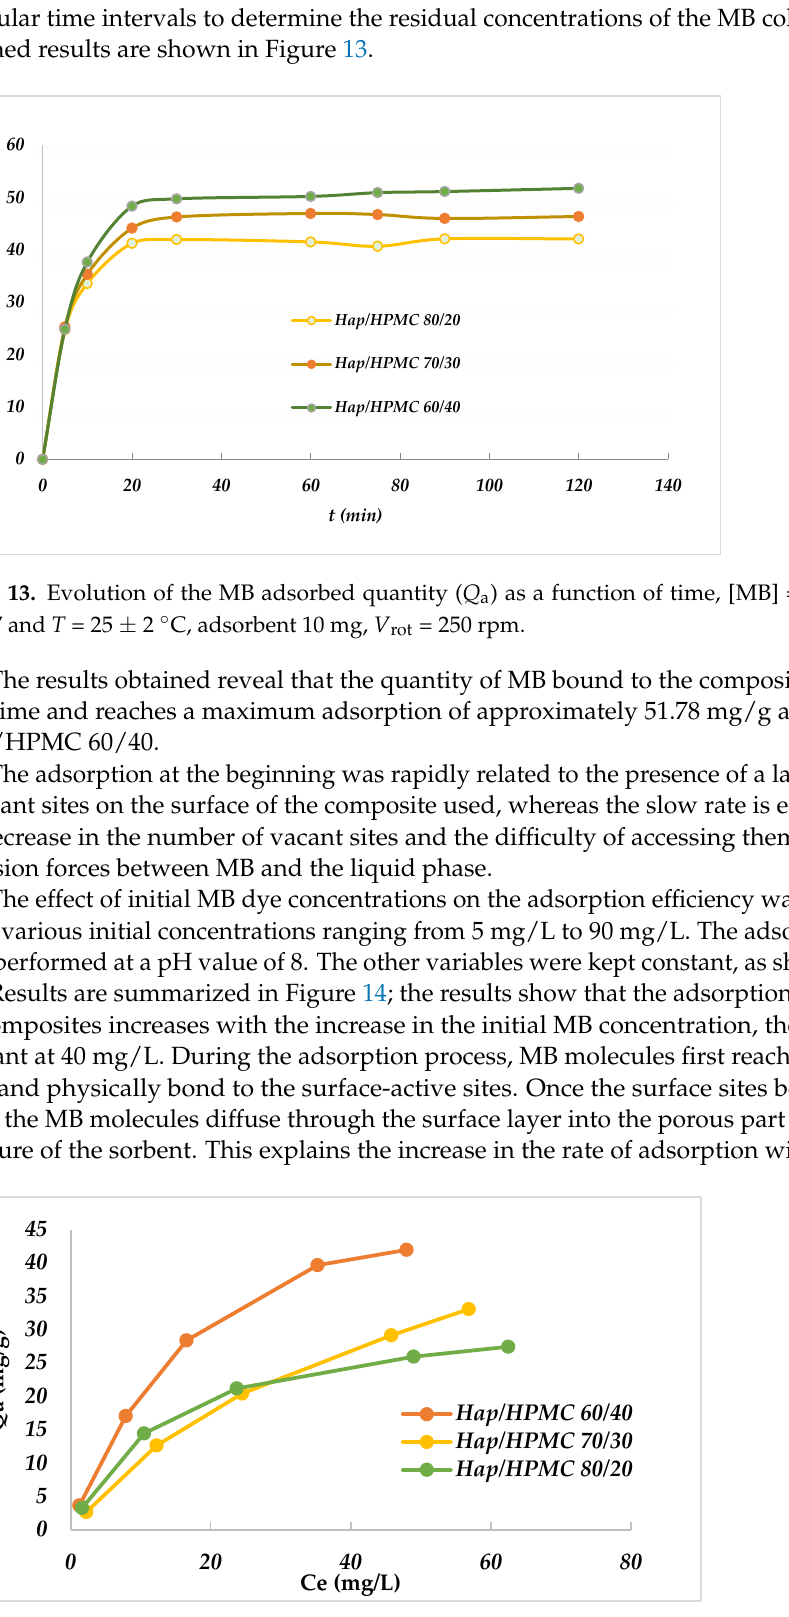
Figure 14. Evolution of the adsorbed quantity as a function of the MB concentration, pH = 7, T = 25 ± 2 °C and V rot = 250 rpm.